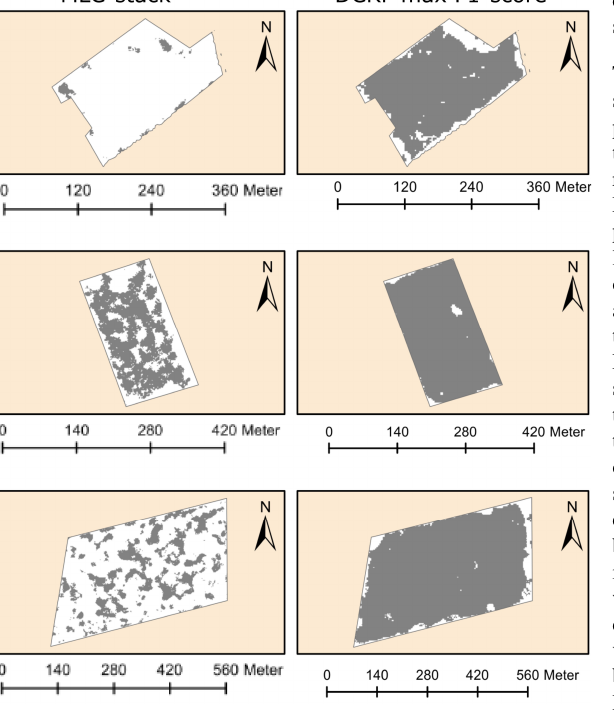
Figure 9. Maps of selected crops: top to bottom row represent oats, sugar beet, and maize parcels respectively. Correctly classified regions are illustrated in grey colour.